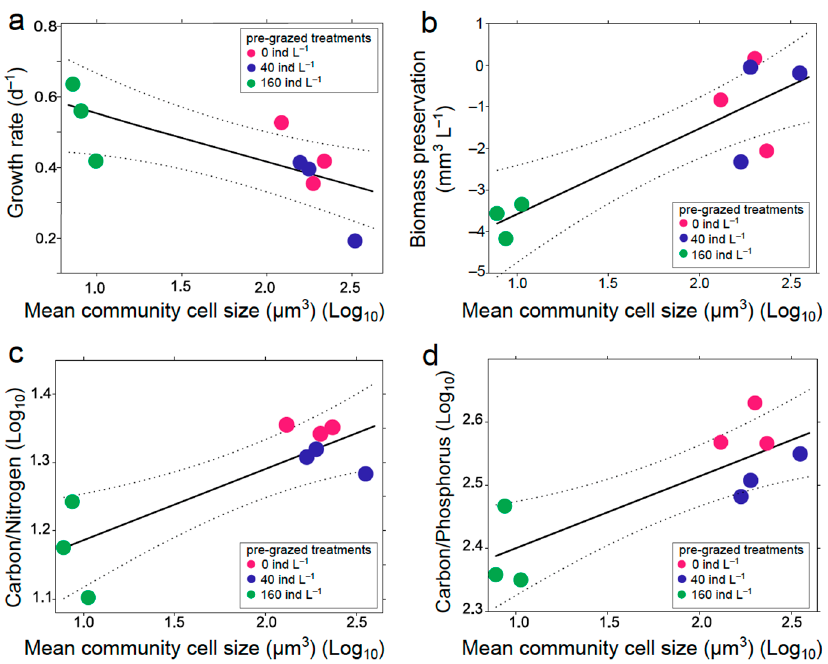
Figure 3. Regressions of ( a ) community growth rate (short-term response, experimental days 1–3), ( b ) postbloom biomass loss from day 3 to 10, ( c ) carbon/nitrogen, and ( d ) carbon/phosphorus ratios in nutrient treatments (N) at day 10 of nutrient phase in response to mean community cell size. Dashed lines show 95% confidence intervals.